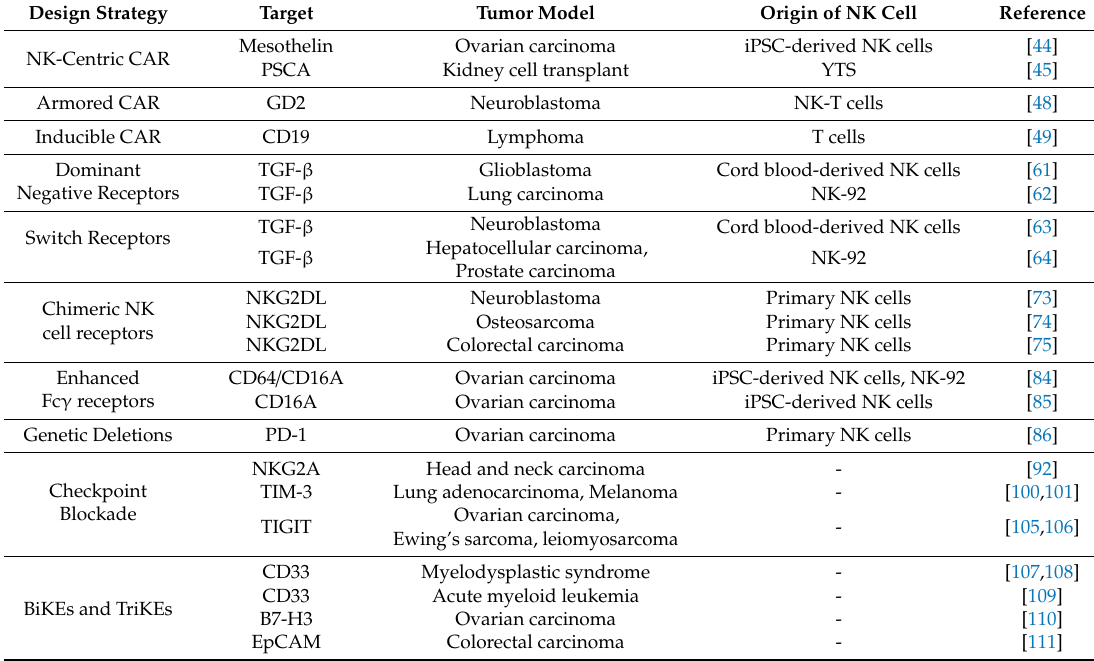
Table 1. NK cell therapeutic strategies. Summary of design and implementation strategies and approaches to augment therapeutic responses of NK cells in the solid tumor